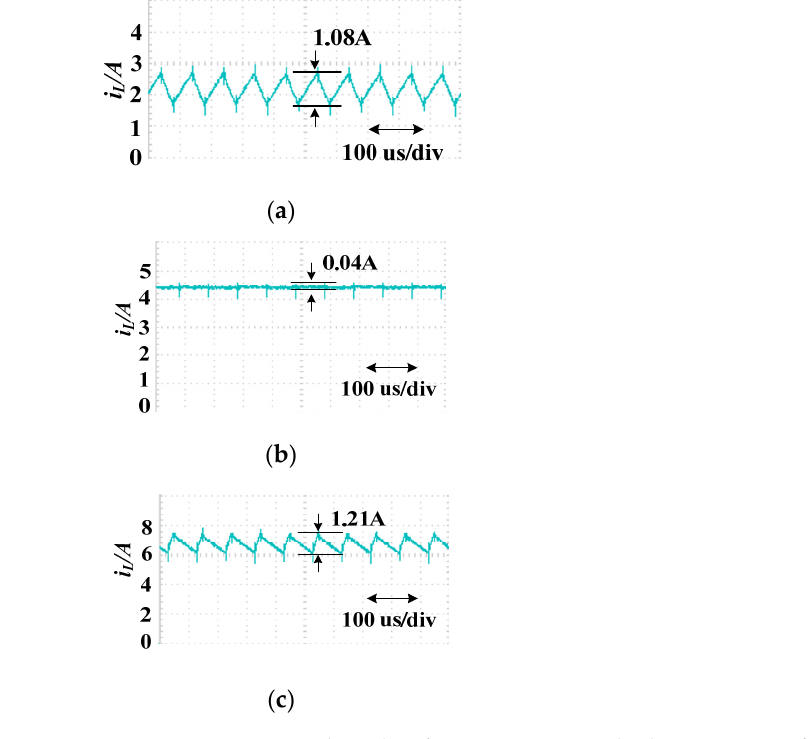
Figure 12. Experimental results of input current ripple characteristics of parallel circuit. ( a ) D = 0.3; ( b ) D = 0.5; ( c ) D = 0.6.